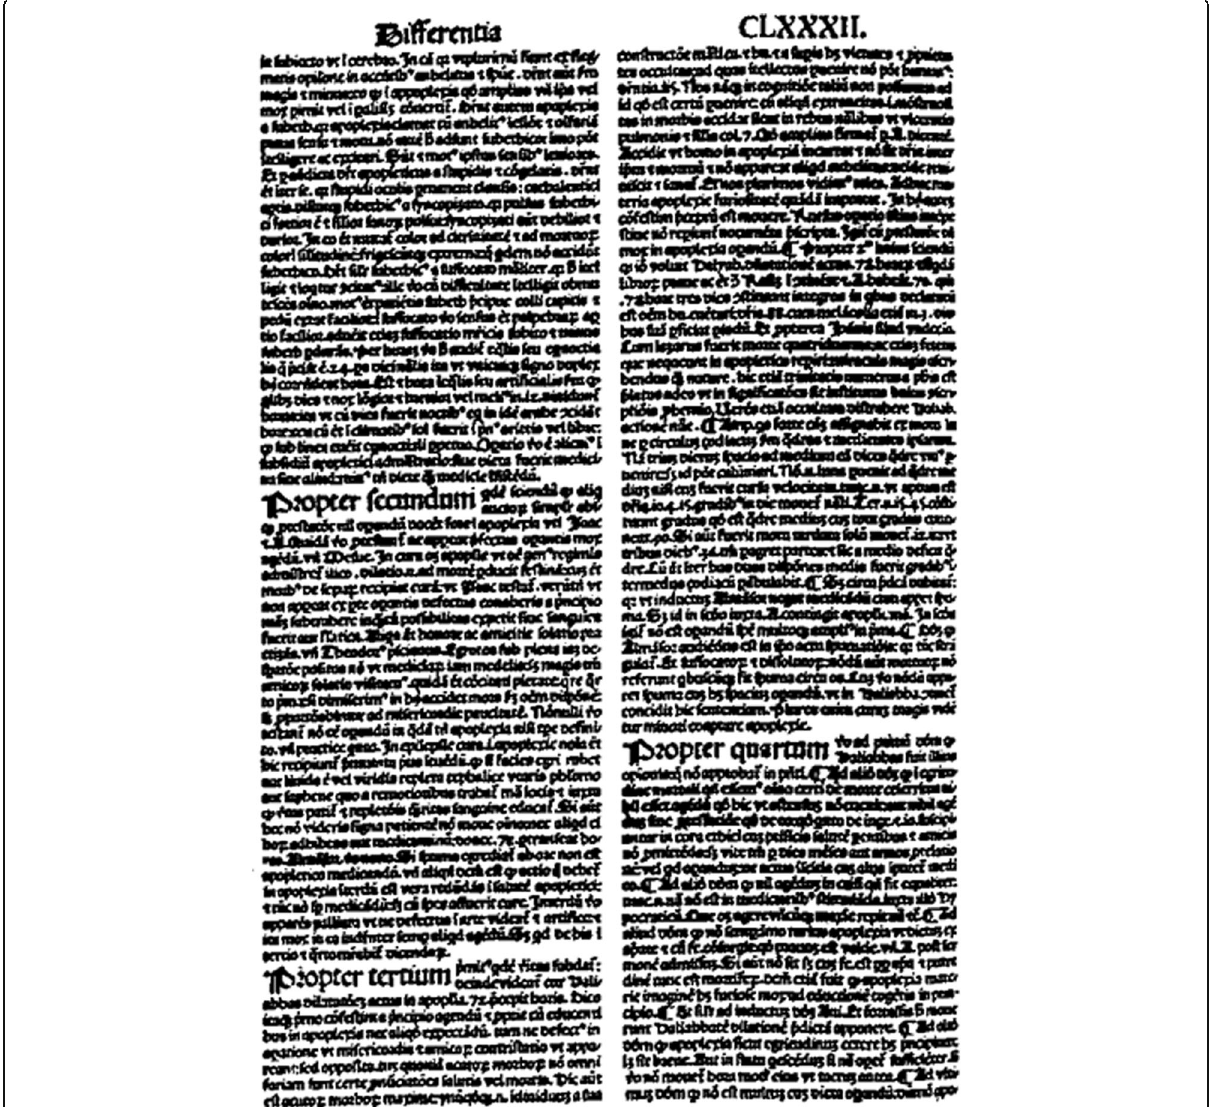
Fig. 4 Folio page from Pietro d ’ Abano ’ s Conciliator (1496). With permission of the University and City Library of